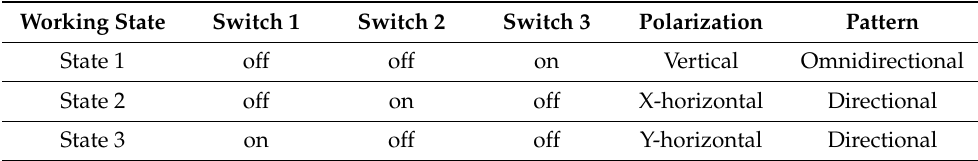
Table 3. Relationship between working state of antenna and